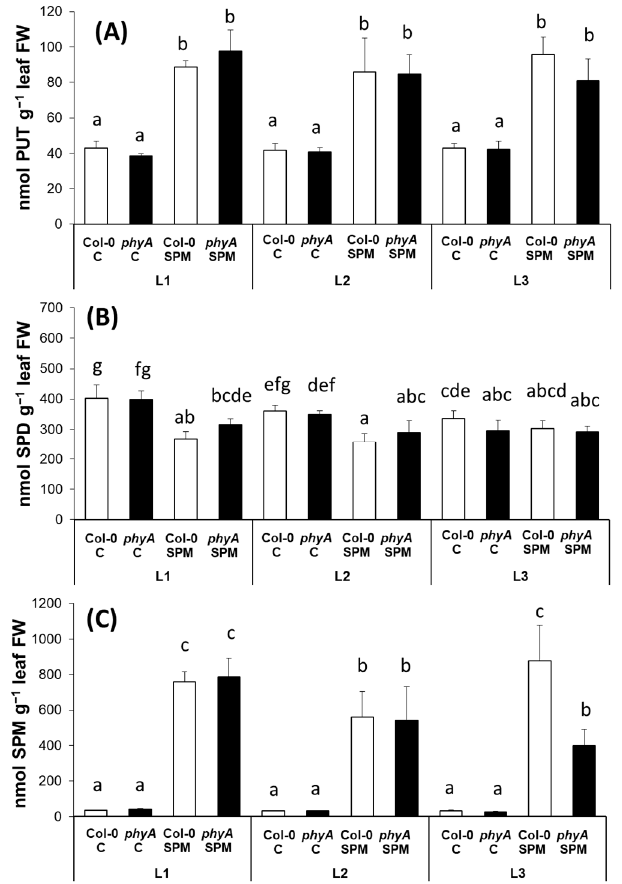
Figure 3. Polyamine contents, namely putrescine (PUT) ( A ), spermidine (SPD) ( B ) and spermine (SPM) ( C ) of wild type (Col-0) and mutant ( phyA ) Arabidopsis plants grown under three di ff erent light regimes (L1: blue%: 19.139, green%: 30.62, red%: 48.8 and far-red%: 1.44; L2: blue%: 19.57, green%: 29.57, red%: 40.43 and far-red%: 10.43; L3: blue%: 39.38, green%: 28.76, red%: 30.53 and far-red%: 1.33) treated with or without 0.5 mM spermine (control: C and spermine: SPM). Values are means ± SD (n = 3). Di ff erent le tt ers indicate statistically signi fi cant di ff erences at p < 0.05 level, using Duncan’s post hoc test.